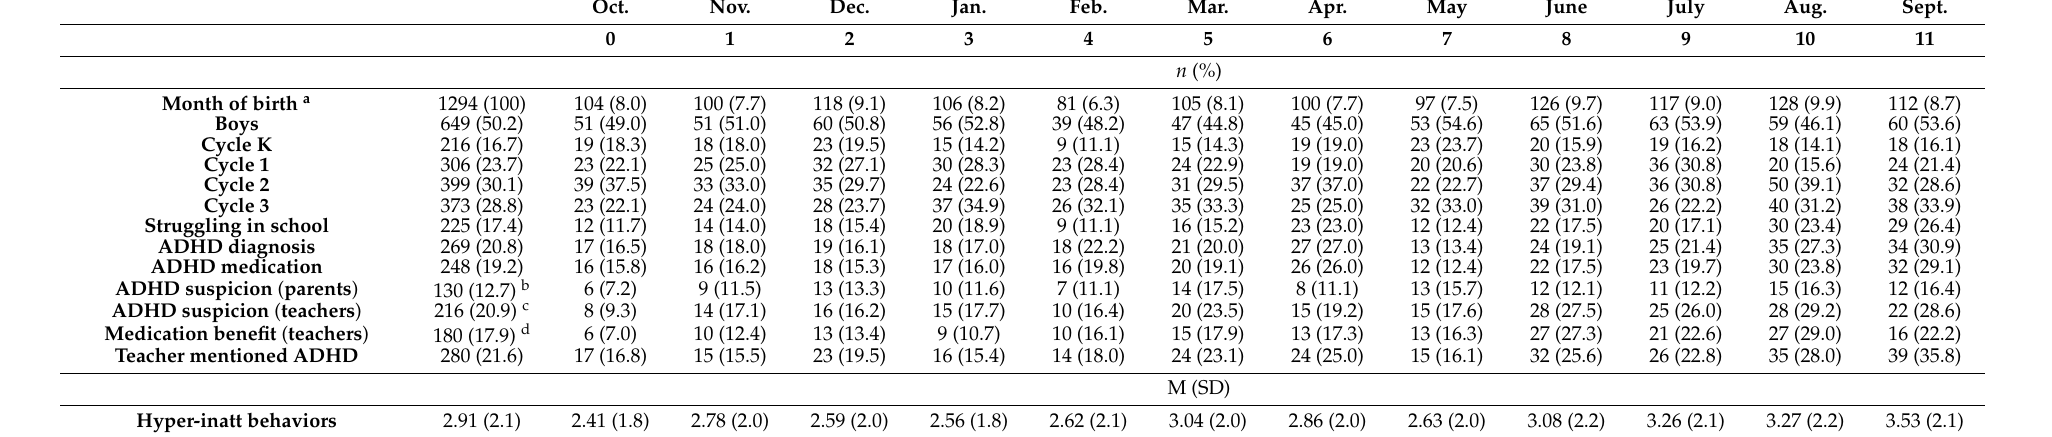
Table 1. Descriptive statistics of ADHD-related outcomes and children’s characteristics by birth month ( n = 1294).